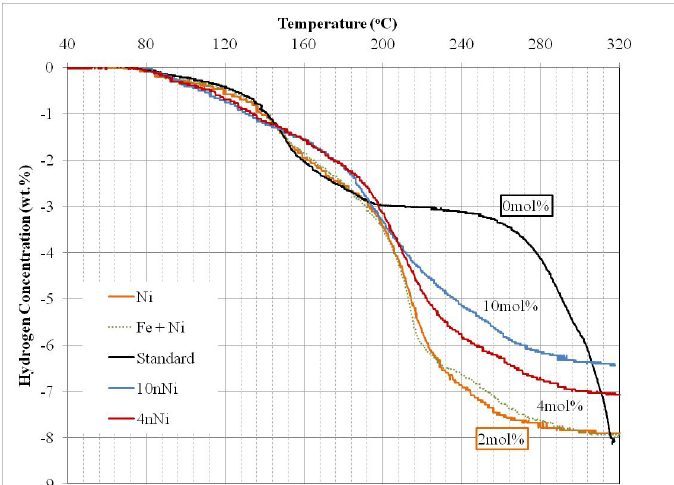
Figure 6. Ramping desorption kinetics of LiBNH + n MgH 4 mol% and 10 mol% nano